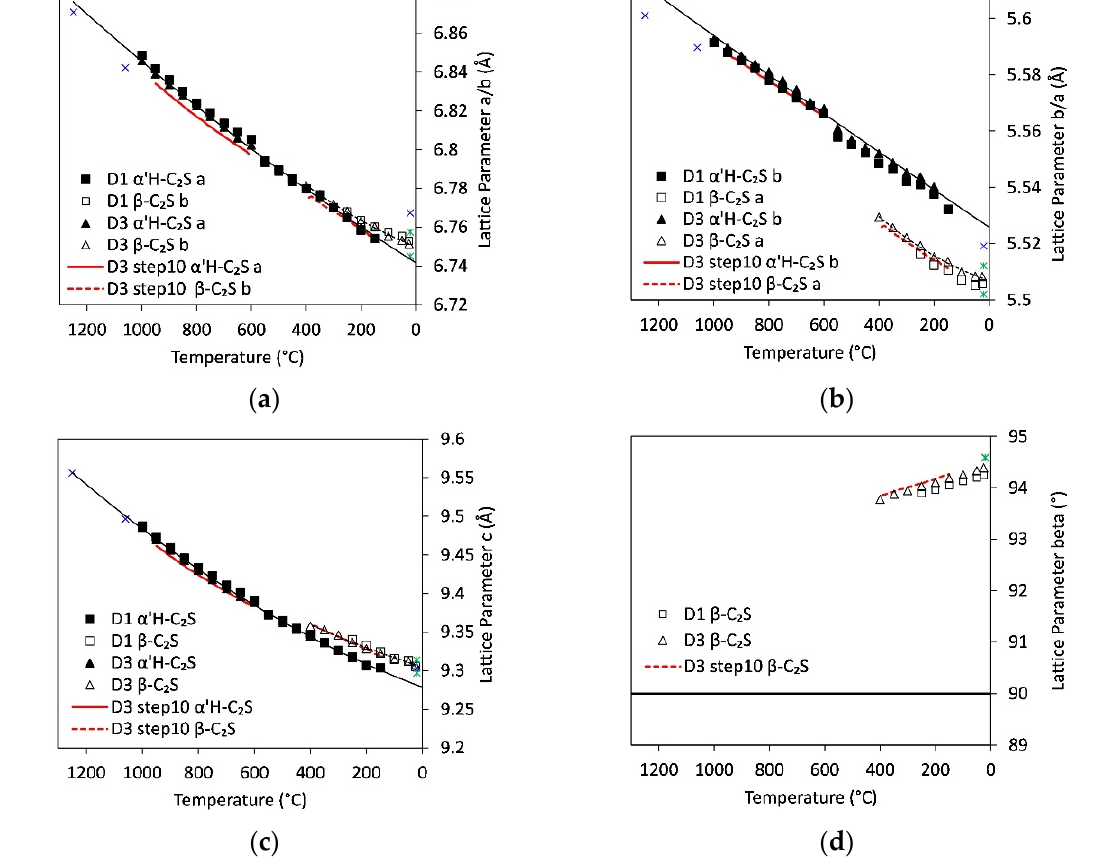
Figure 6. Variation of lattice parameters of α ’H-C 2 S and β -C 2 S in D1 and D3 with cooling. Lattice parameters of D2 are similar to D3. Experiment with low heating and cooling rate is shown between 950 °C and 600 °C and 400 °C and 150 °C as red lines. ( a ) a -/ b -axis, ( b ) b -/ a -axis for α ’H-C 2 S and β -C 2 S, ( c ) c -axis, and ( d ) beta angle. For comparison, the line at 90° for the β -angle in the orthorhombic structure of α ’H-C 2 S is depicted. Literature data of α ’H-C 2 S, α ’L-C 2 S (blue crosses), and β -C 2 S (green stars) are shown in the graphs [35,39,40].